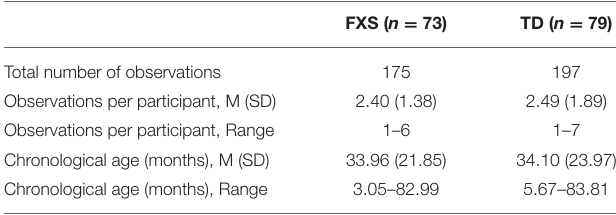
TABLE 1 | Participant characteristics: research question 1. TABLE 2 | Participant characteristics at outcome timepoint: research question